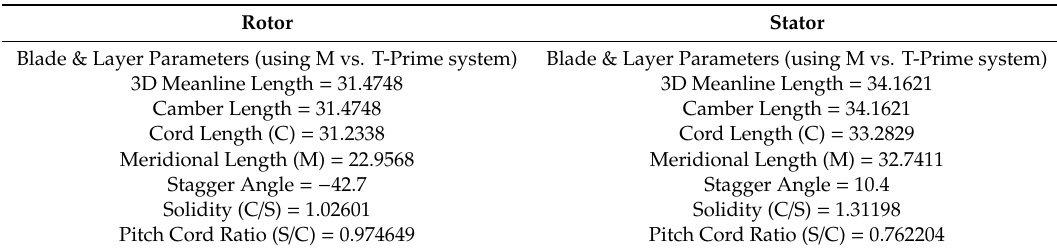
Table 13. Preliminary blade